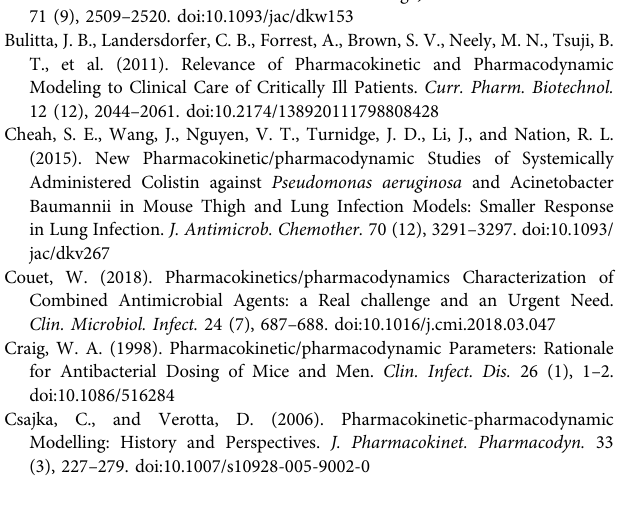
Frontiers in Pharmacology |